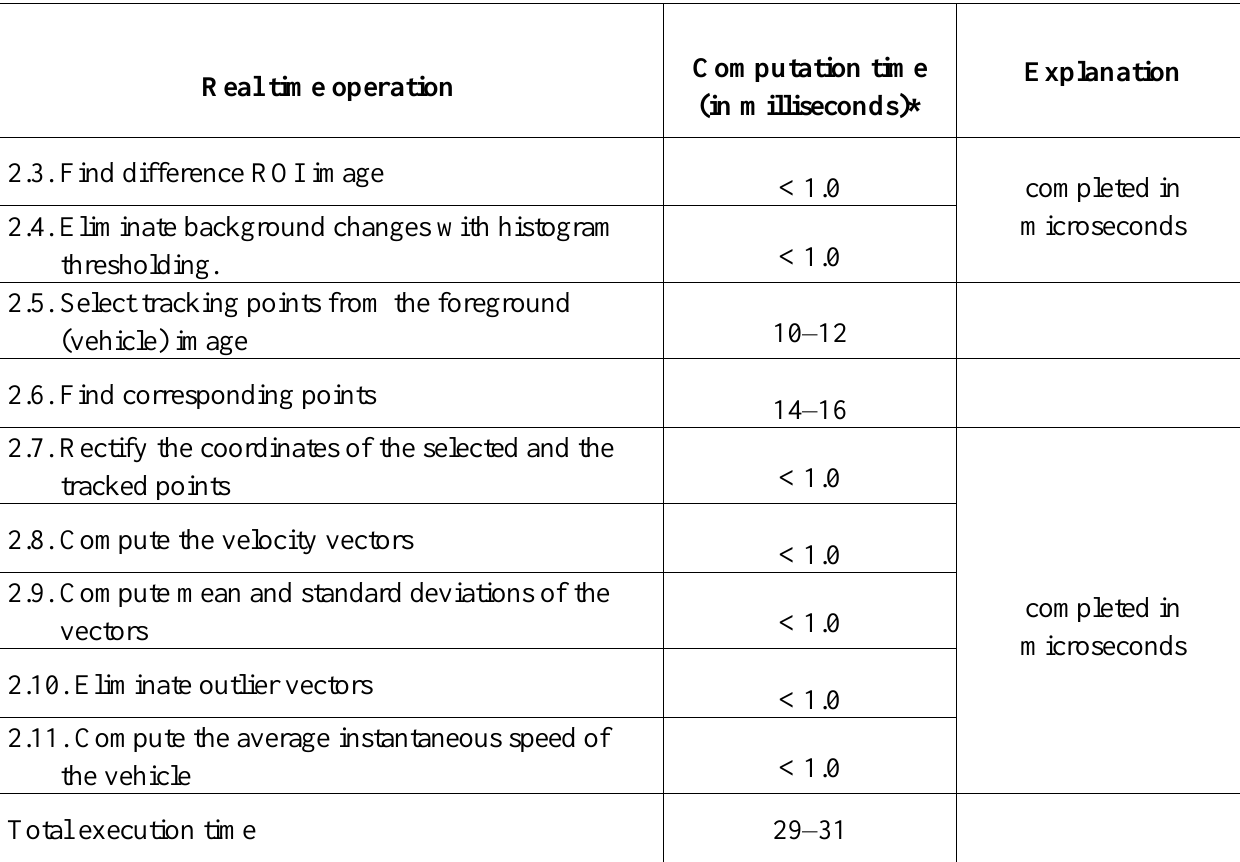
Table 2. Computation times of real time